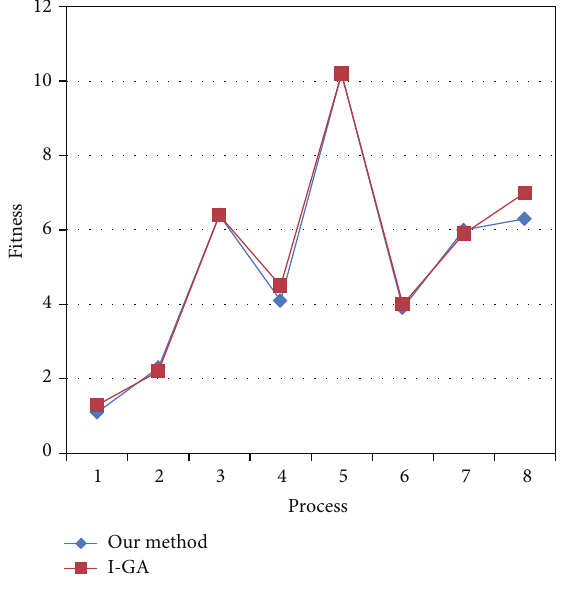
Figure 5: Comparison of